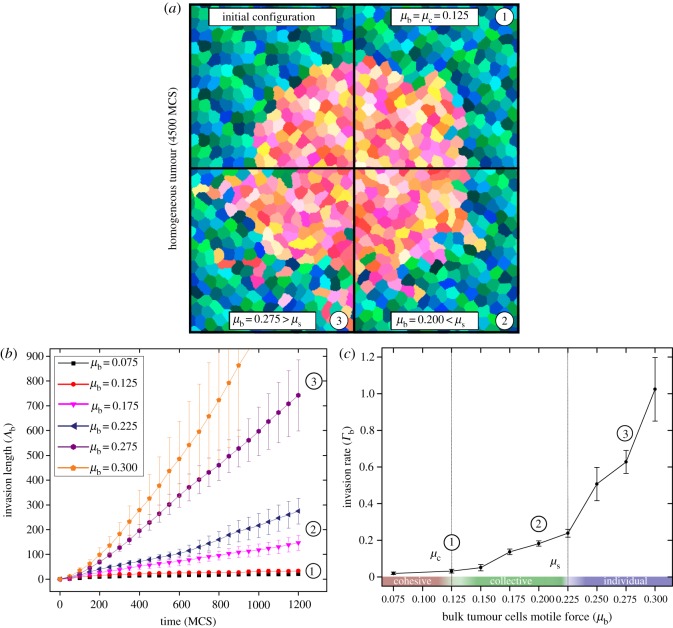
Collective invasion for homogeneous tumours. (a) Snapshots of in silico experiments. Top-left quadrant represents the initial state of the system (green–blue cells are non-motile, yellow–red cells are bulk tumour cells). The three other quadrants (1–3) represent the state of the system for different values of μb at t=4500 MCS. (b) Invasion length of bulk tumour cells Λb with respect to time, for different values of μb. (c) Invasion rate Γb with respect to μb. Details on the computation of plotted quantities from in silico experiments are provided in the electronic supplementary material. μc and μs values relate to cell migration behaviour transitions. Error bars are the standard error of the mean (s.e.m.).